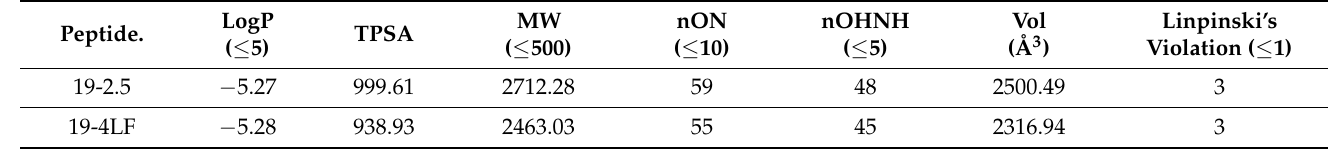
Table 3. Drug oral bioavailability parameters of 19-2.5 and 19-4 LF peptides.